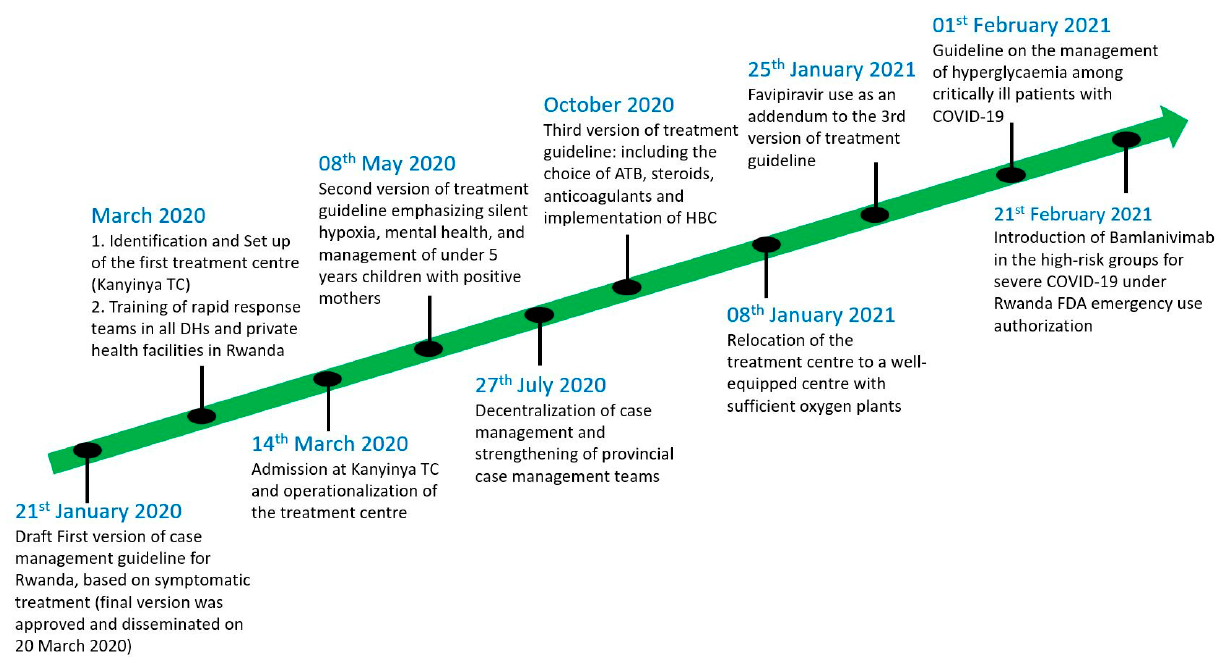
Figure 1. Timeline of COVID-19 case management interventions.